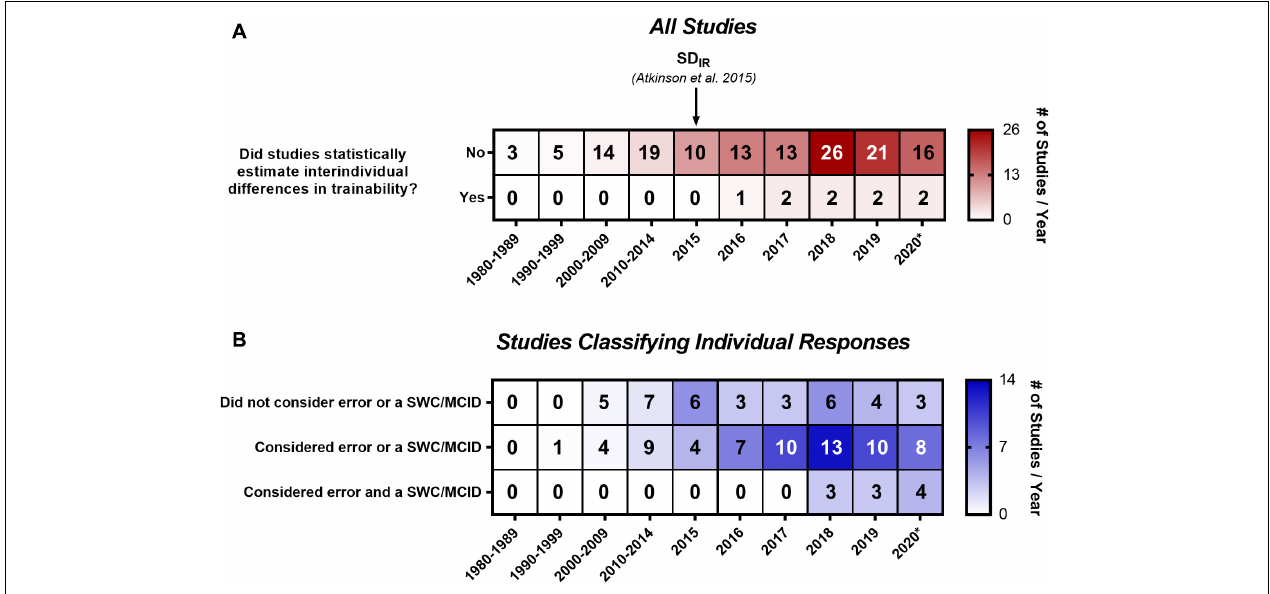
FIGURE 2 | Timeline and heatmap of the 149 studies included in our systematic review. Numbers refer to a total number of studies in each cell, whereas shading depicts the total number of studies divided by the number of years included in that column. (A) Includes all studies sorted by whether studies used a statistical approach to estimate interindividual differences in trainability, and (B) includes the 116 studies that classified individual responses sorted by the classification categories outlined in Table 2 . 2020* includes studies published in 2020 and up to the updated literature search (January 6, 2021). MCID, minimum clinically important difference; SD IR , the standard deviation of individual responses; SWC, smallest worthwhile change. (B) Only contains 113 of the 116 studies that classified individual responses because three studies did not report how individuals were classified (Hubal et al., 2005; Hagstrom and Denham, 2018; Peltonen et al.,